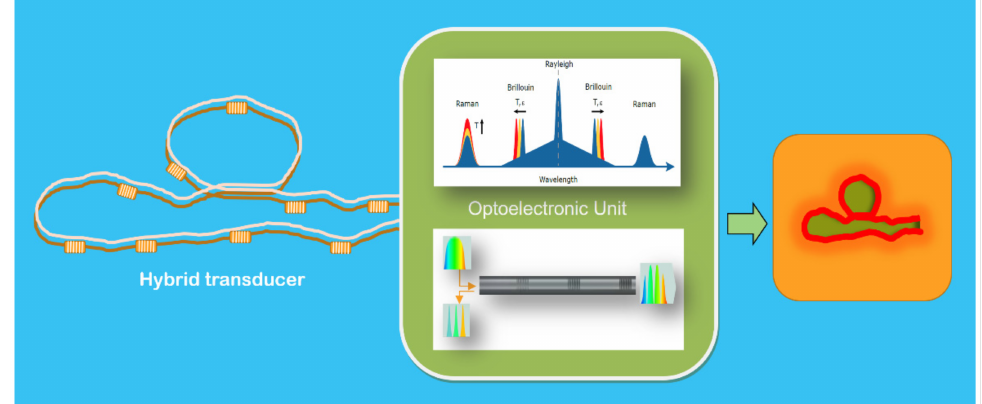
Figure 7. A general schematic illustration of a versatile Hybrid Optical Fiber Sensor for distributed high-temperature industrial processes monitoring. The hybrid transducer is composed of one or two fibers (unsubmitted to any elongation) inside a special cable: (a) when the cable contains only a fiber, a set of Fiber Bragg Gratings (FBGs), able to work correctly at the specified high temperatures, is placed along with transducer fiber; (b) when two fiber are inside the cable then in one of them a set of high-temperature FBGs are placed along with the fiber to quasi-distributed temperature measurements, and the other one is there to do the distributed temperature determination along with the fiber with a given resolution. In both cases, the temperature offered using FBGs is also used to calibrate the distributed measurements. In the OU, Raman Scattering and tunable laser- based sub-sections (in different wavelength rages) interrogate both the distributed and the quasi distributed transducer transducers. The appropriate signal processing enables the determination of the distributed temperature along the length of the transducer cable. The results are presented in a proper synthesized image representative of the spatial high-temperature distribution on/in the object in which the transducer is installed, and (if required) some specific intelligence is added; actuation signals can be offered at the OU’s output. Courtesy of the